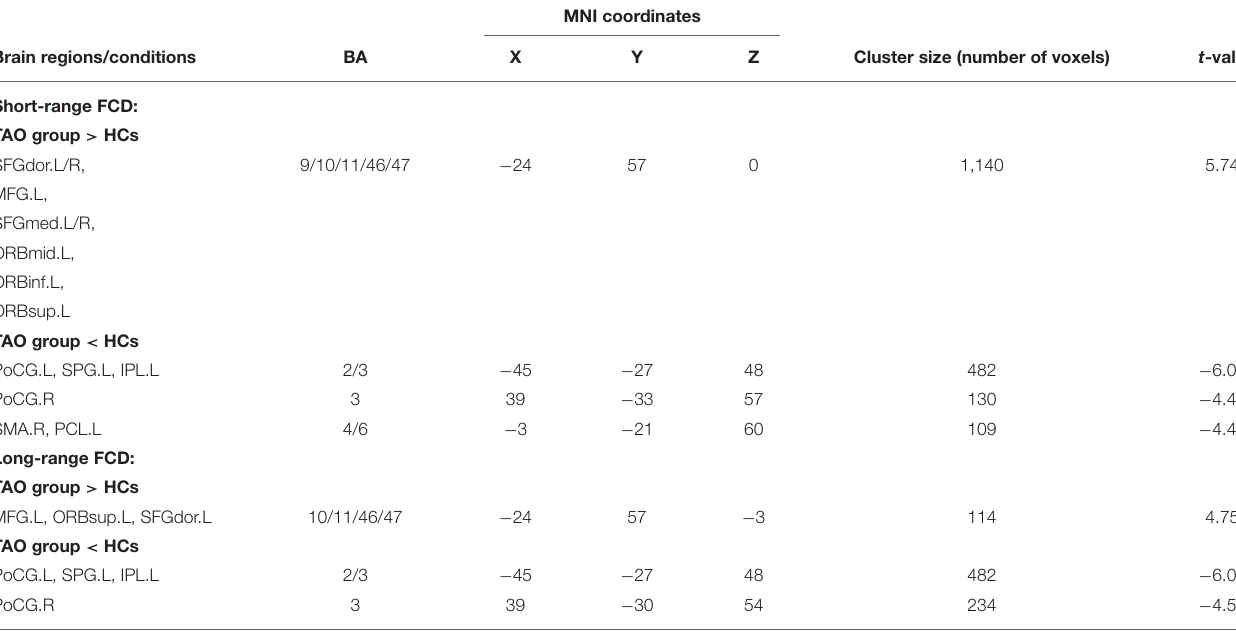
TABLE 2 | Brain areas with significantly different short- and long-range FCD values between groups ( P < 0.05, cluster-level FWE-corrected). MNI